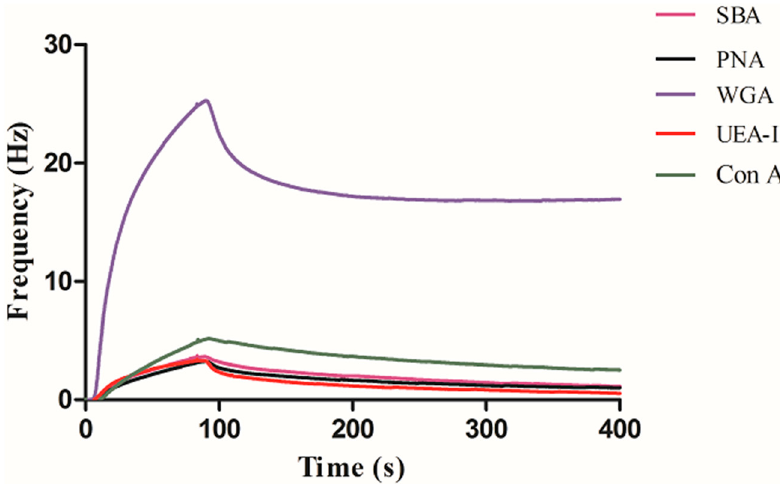
Figure 5. Interaction of GlcNAc with a series of lectins.